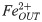
DMT1 binary switching-mechanism model.Considers DMT1’s endocyted state (P5). In this case, iron is released to the intracellular medium from the vesicle via DMT1. (orange circle): apical iron concentration (FeOUT2+); (brown circle): iron concentration in the intracellular-basolateral space (FeIN2+). Extracellular iron FeIN2+ is considered to be a regulatory factor in endocytosis, represented as dashed modulator arrow (-- •).